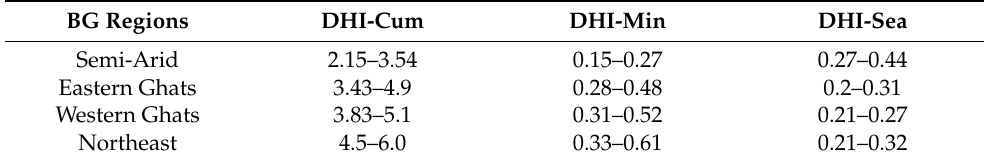
Figure 8. Schematic representation of three DHI components using the 3-D scatter plots (DHI-cum in x-axis, DHI-min in y-axis, DHI-sea in z-axis) during 2001–2015 for the four biogeographic regions of India, where: ( a ) semi-arid; ( b ) eastern Ghats; ( c ) Western Ghats; ( d ) Northeastern region. Table 1. Distribution of DHI values of all components in four biogeographic regions.